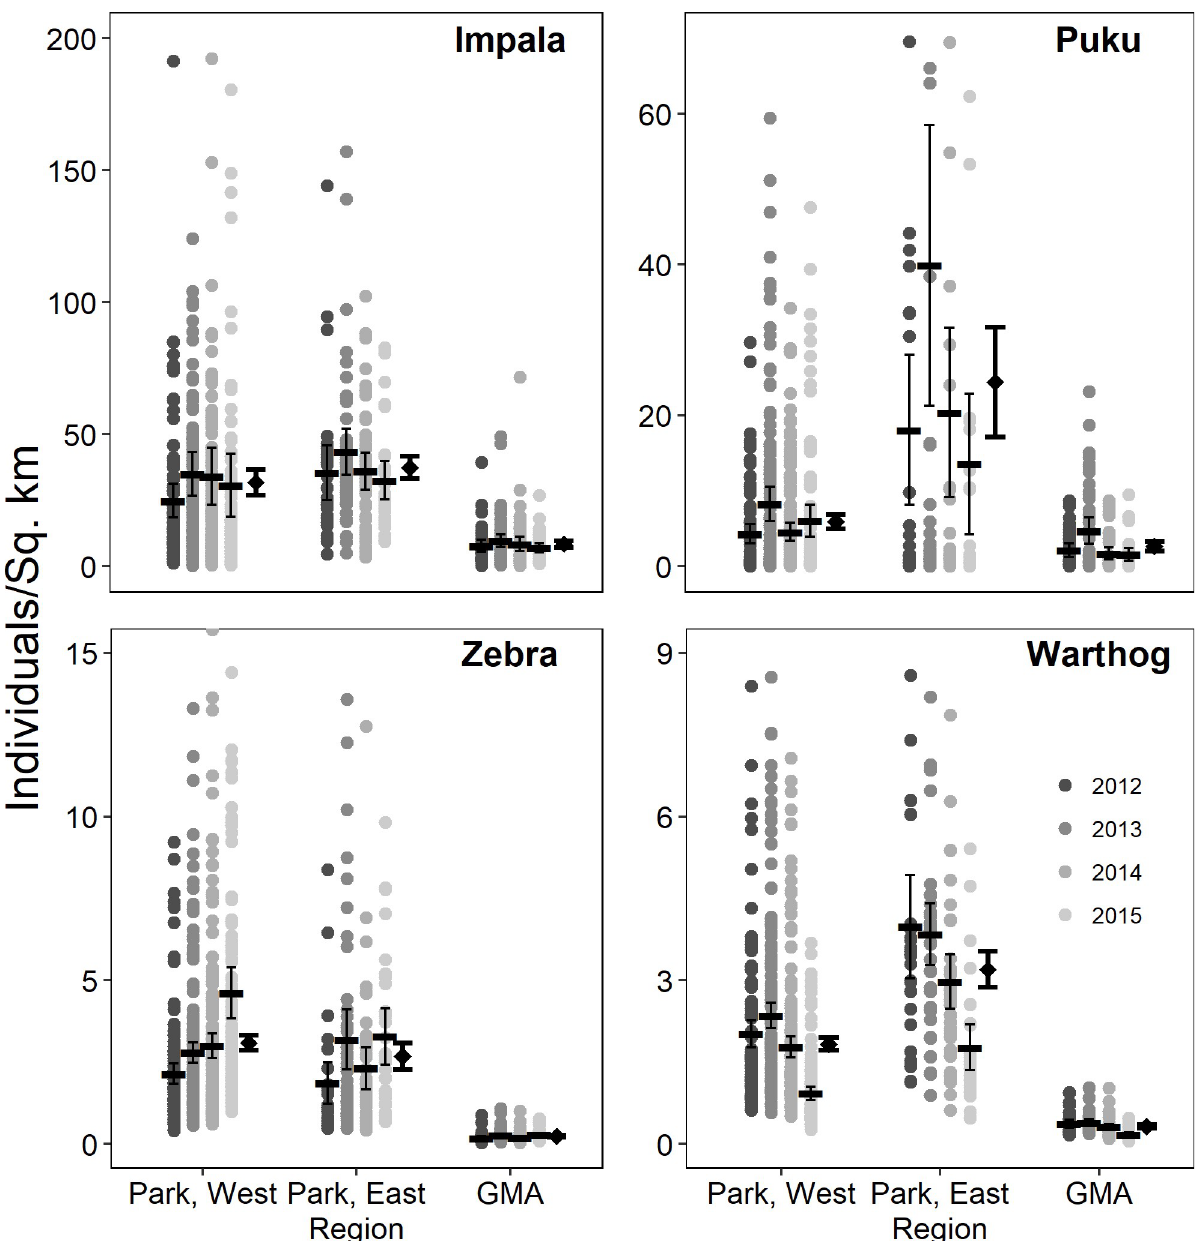
Fig 2. Population density estimates across the South Luangwa protection gradient. Regions are arranged left to right in level of protection, with west and east denoting side of the Luangwa River. Points indicate segment-specific density estimates across the four-year study, overlaid with average annual densities and 95% CIs. Overall regional average densities (diamonds) and 95% CIs are displayed in bold alongside the annual averages. Y-axes were truncated to clearly display variation between annual averages, and thus omit extreme segment estimates from being displayed (13 impala, 16 puku, 4 Zebra, and 3 warthog estimates out of 890 total estimates for each